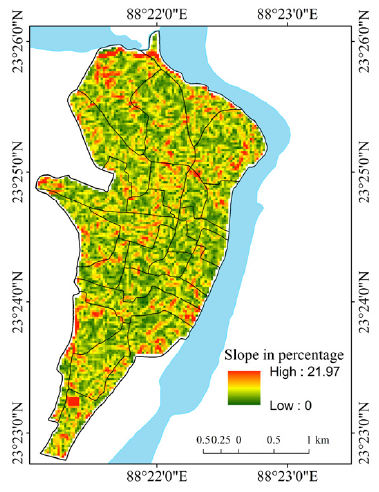
Figure 15. Slope (2000).